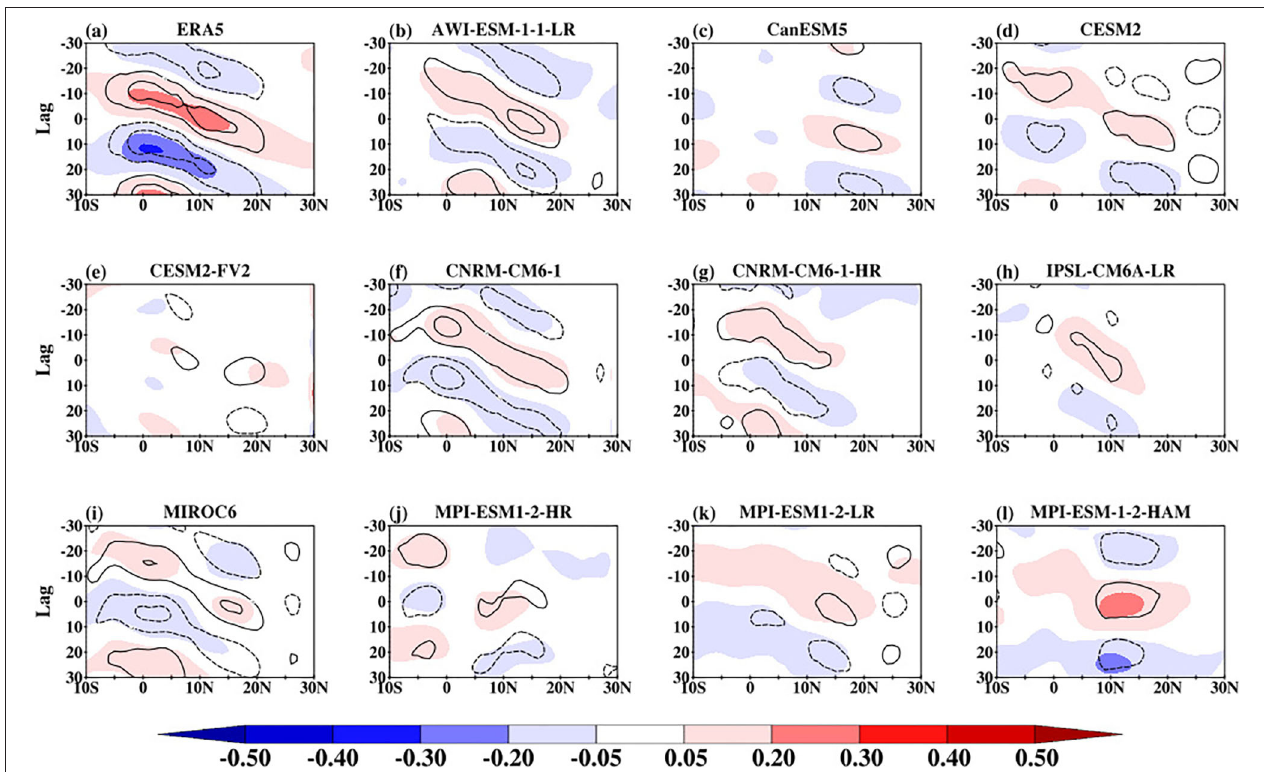
FIGURE 11 | Northward propagation of observed (a) and simulation (b–l) BSISO convection signal indicated by column integrated MSE (shaded) and 30–60-day rainfall anomalies (contours; starting from ± 0.2 to ± 0.6 at an interval of 0.2) averaged over 100 ◦ E–120 ◦ E by lag-correlation against 30–60-day rainfall anomalies averaged over the southeast Asia (5 ◦ N and 20 ◦ N, 100 ◦ E and 120 ◦